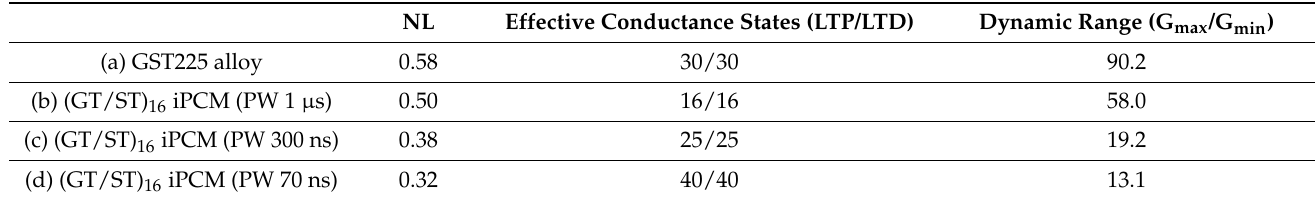
Table 1. Summary of synaptic characteristics of GST225 alloy and (GeTe/Sb 2 Te 3 ) 16 iPCM. NL